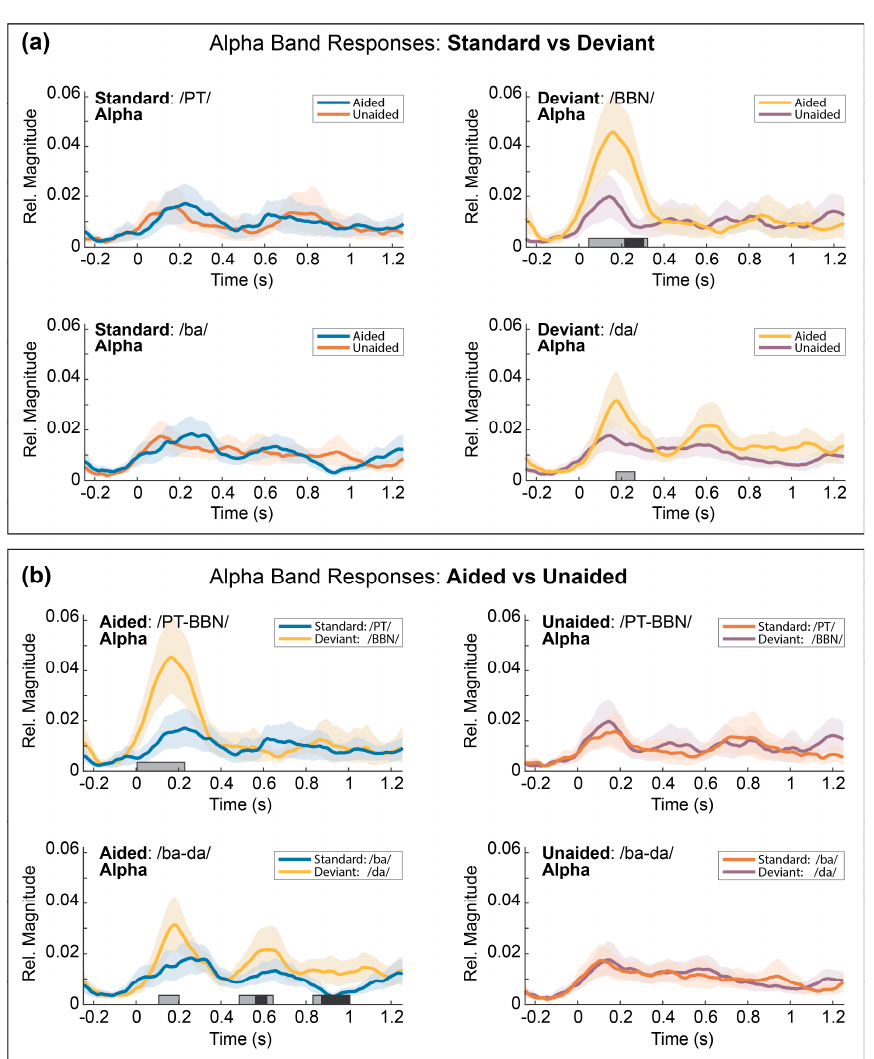
Figure 5. Mean temporal envelopes of alpha band coherence: planned comparisons . ( a ) Mean temporal envelopes for the alpha band coherences showing comparisons of the standard versus deviant responses for each contrast and each listening condition. Responses for the/PT-BBN/contrast are shown in the upper row and responses for the/ba-da/contrast are shown in the bottom row. Responses are shown for the aided condition (left column) and responses for the unaided condition (right column). The shaded regions around each temporal envelope represent the 95% confidence intervals for the group mean and the shaded bars along the abscissa represent time regions with significant differences between the aided and unaided responses (gray = p < 0.05, black = p < 0.01). ( b ) Mean temporal envelopes for the alpha band coherences showing comparisons of the aided versus unaided responses for each stimulus. Responses for the/PT-BBN/contrast are shown in the upper row and responses for the/ba-da/contrast are shown in the bottom row. Responses for the standard stimulus of each contrast are shown in the left column and responses for the deviant stimulus for each contrast are shown in the right column. The shaded regions around each temporal envelope represent the 95% confidence intervals for the group mean and the shaded bars along the abscissa represent time regions with significant differences between the aided and unaided responses (gray = p < 0.05, black = p <